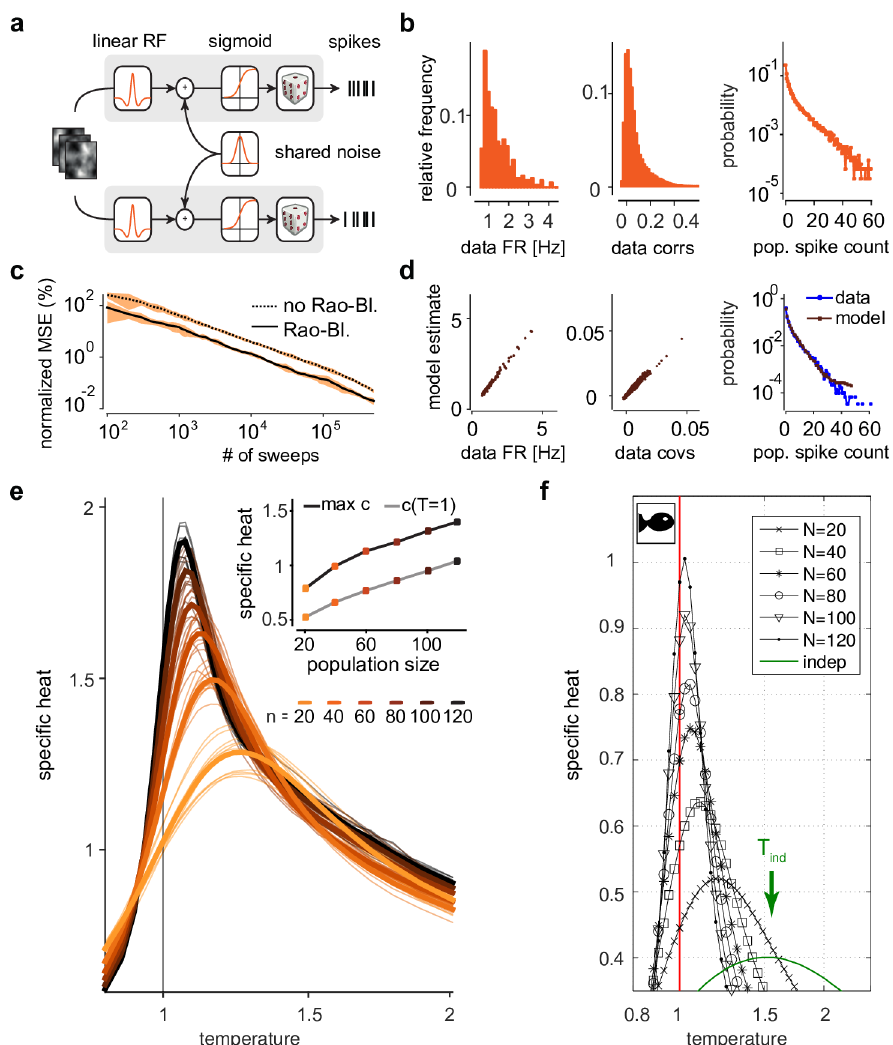
Fig 2. Signatures of criticality in a simulation of retinal ganglion cell activity. a) Simulationschematic: Neuronshave linear stimulus selectivity with centre-surround receptivefields and correlatedGaussiannoise. b) Statistics of simulatedpopulationactivity. Histograms of firing rates (left), correlationcoefficients (centre) and frequency of population spike-counts (right). c) Estimation-error (normalised mean squareerror) in pairwisecovariances as function of sample size, averaged across 10 populationsof size n = 100. Rao- Blackwellizationreducesthe number of samplesneededfor a given level of accuracy by a factor (cid:25) 3. d) Quality of fit: Populationmodels (here n = 100, examplepopulation)capture the mean firing rates (left), covariances (centre) and spike-counts (right). e) Divergenceof specific heat: Average and individual traces for 10 randomly sampledpopulationsfor each of 6 different population sizes, exhibitingdivergence of specific heat and peak in heat near unit temperature. Inset: Specific heat at unit temperature and at peak vs. population size. f) Specific heat for different temperatures and subsampled populationsizes (here denotedby capitalletter N ) in recordingsof salamander retinal ganglioncells responding to naturalisticstimuli, reproducedfrom